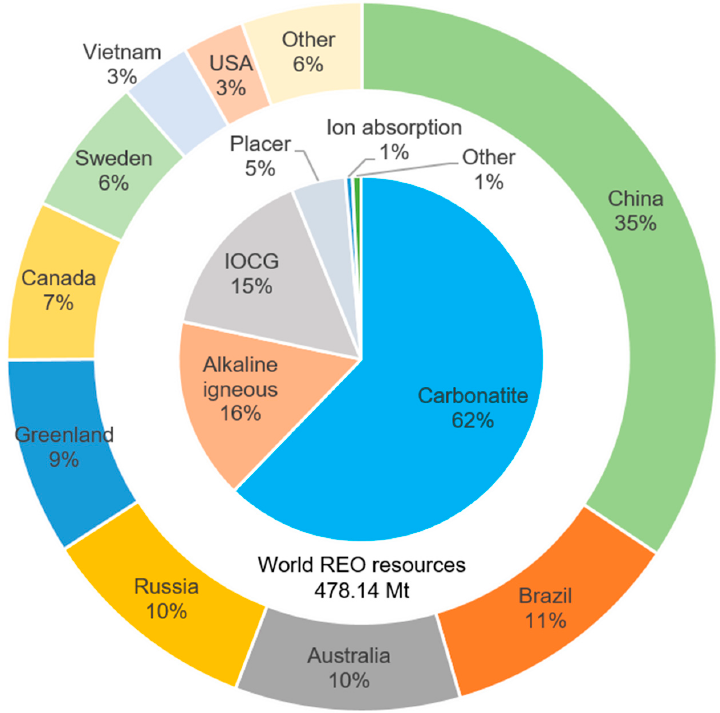
Figure 3. The distribution of global rare earth resources by principle deposit type and country.